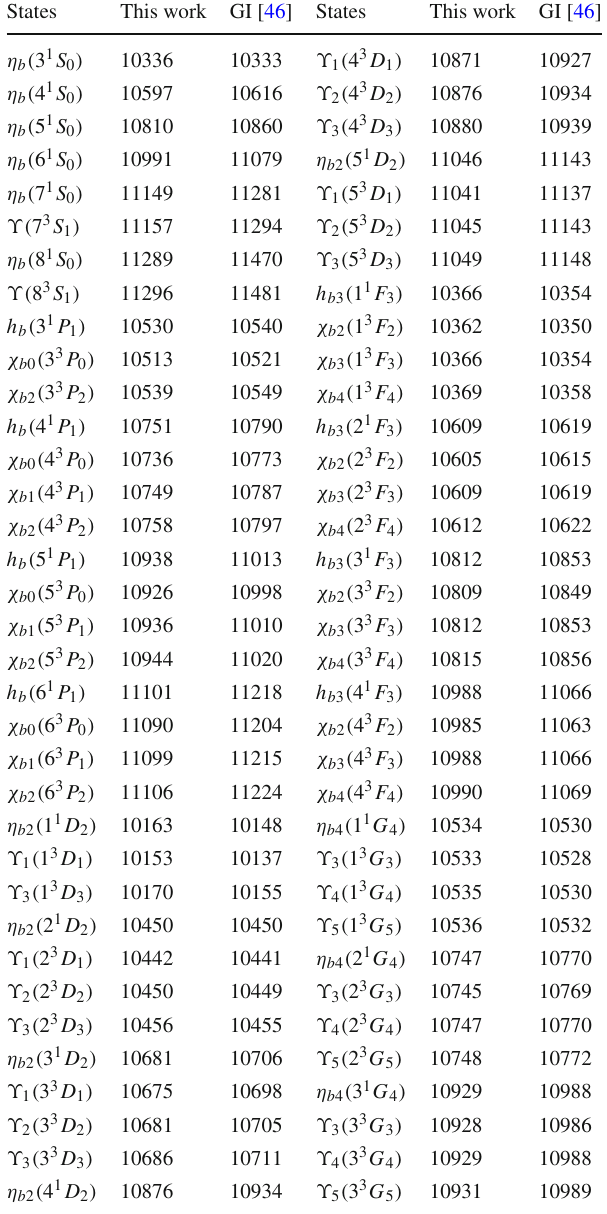
Table 3 The mass spectrum of the predicted bottomonia. All mass values are in units of MeV